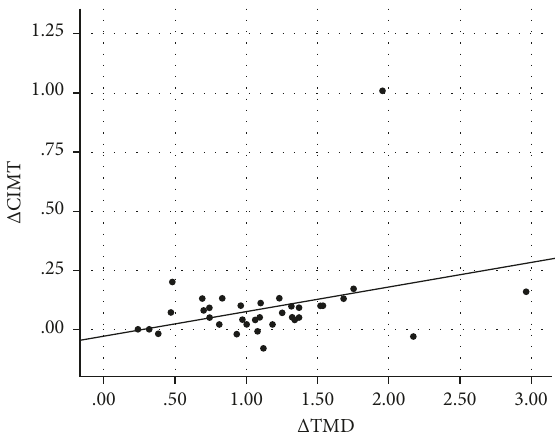
Figure 6: Scatter plot graph